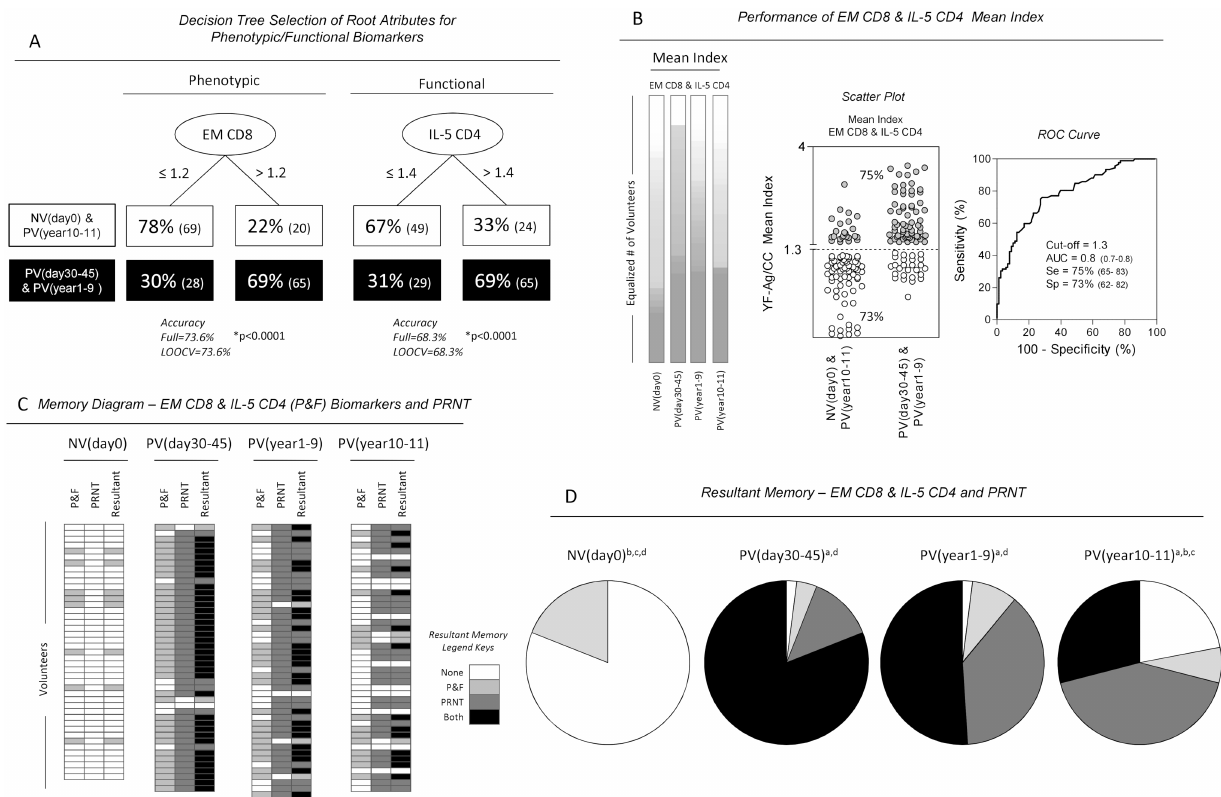
Fig 4. Major phenotypic/functional biomarkers useful to monitor the memory status following primary 17DD-YF vaccination. (A) Decision tree analysis was carried out to identify root attributes [Ellipses] for phenotypic/functional (P&F) biomarkers amongst NV(day0)&PV(year10-11) [white rectangle] and PV(day30-45)&PV(year1-9) [black rectangle], considered biomarkers to discriminate unprotected from protected subjects. Leave-one-out- cross-validation analysis (LOOCV) was employed to minimize biased performance estimates by using all data set for decision tree model fitting. EMCD8 and IL-5CD4 were selected as major phenotypic and functional 17DD-YF Memory-related biomarkers, respectively. (B) Heatmaps were built, taking the mean index of the top-two phenotypic/functional biomarkers (EMCD8 & IL-5CD4) and demonstrating the proportion (%) of volunteers ranging from low (White) to high (Gray) YF-Ag/CC index. A scatter plot was constructed to show the sensitivity (Gray Circle) and specificity (White Circle) of the top- two biomarkers, employing the cut-off edge (Mean Index = 1.3) provided by the ROC curve analysis. (C) Resultant memory status was defined for each subject, considering the top-two biomarkers (Mean Index > 1.3) and PRNT ( > 2.9 Log mIU/mL, according to Sim õ es et al., 2012). Column statistics were used to calculate the proportion of subjects displaying differing categories of resultant memory, referred as none, top-two biomarkers—P&F, PRNT and both. (D) Pie charts illustrated the overall resultant memory status within each category, as determined by the top-two biomarkers and PRNT. Significant differences at p < 0.05 (Chi-square test) of resultant memory status amongst study groups were represented by letters “a”, b”, “c” and “d” in comparison to NV(day0), PV(day30-45), PV(year1-9) and PV(year10-11),